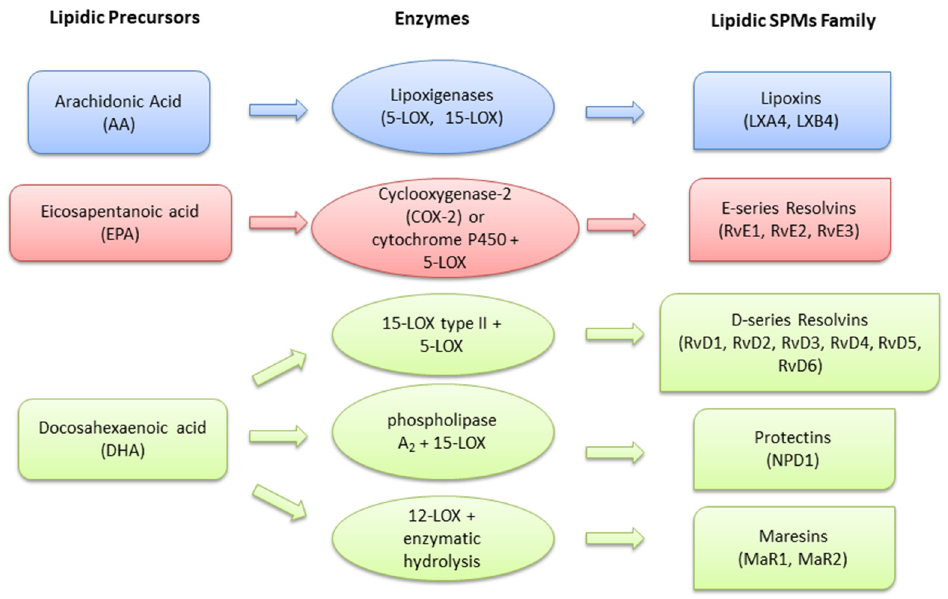
Figure 1. Main lipidic PMs: precursors and biosynthesis enzymes. LOX: lipoxygenase; COX: cy- clooxygenase.